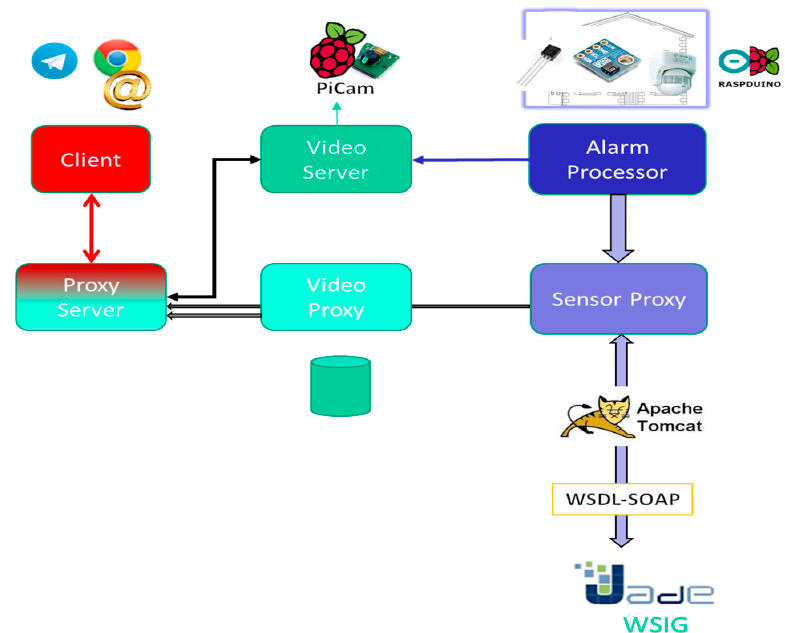
Figure 8. Scheme of the use of free software for the implementation of the components of the video surveillance system.